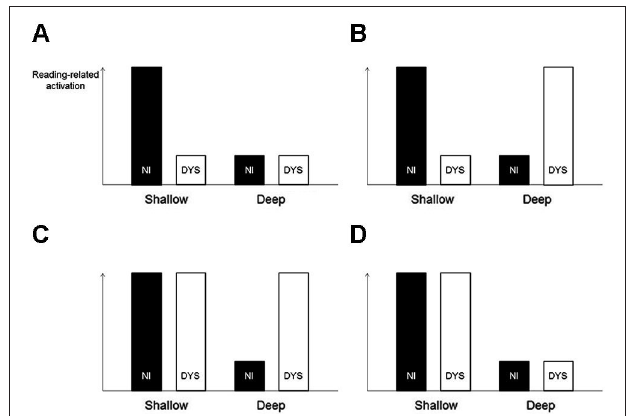
FIGURE 1 | Illustration of different activation patterns of non-impaired (NI) and dyslexic (DYS) readers . The strategy to compare abnormality patterns of dyslexic readers (relative to non-impaired readers) across languages would correctly identify the situations illustrated in sections (A–C) as showing an orthography-specific abnormality pattern and would correctly reject the situation illustrated in section (D) . In contrast, the actual strategy used by Paulesu et al. (2001) (i.e., comparing dyslexic activation directly across languages), would only correctly identify the situation illustrated in section (B) . It would fail to identify the situations illustrated in sections (A) and (C) and would incorrectly identify the situation illustrated in section (D)